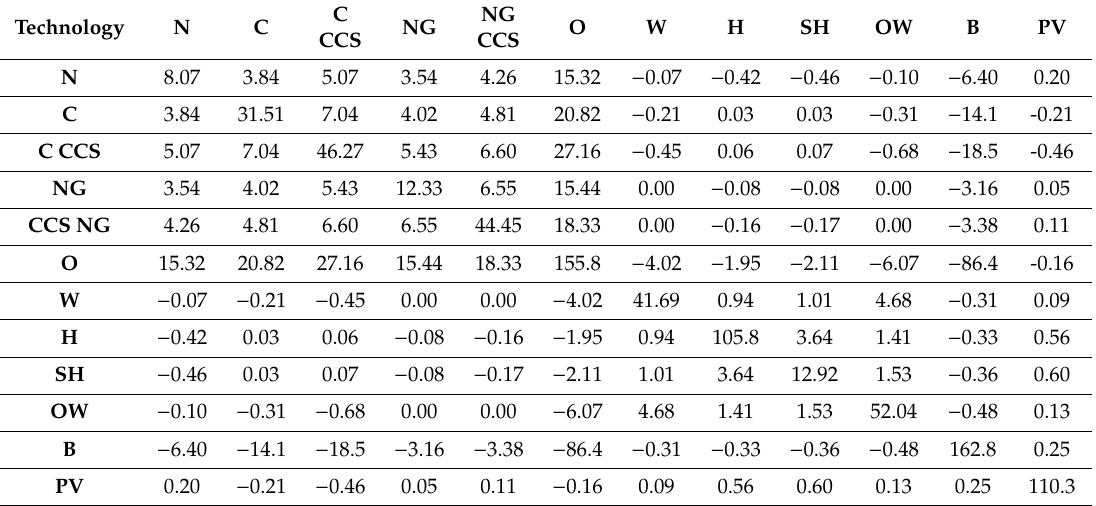
Table 2. Cost variance-covariance matrix. Source: Authors’ own work, based on data collected from DeLlano et al. (2014, 2015) [14].